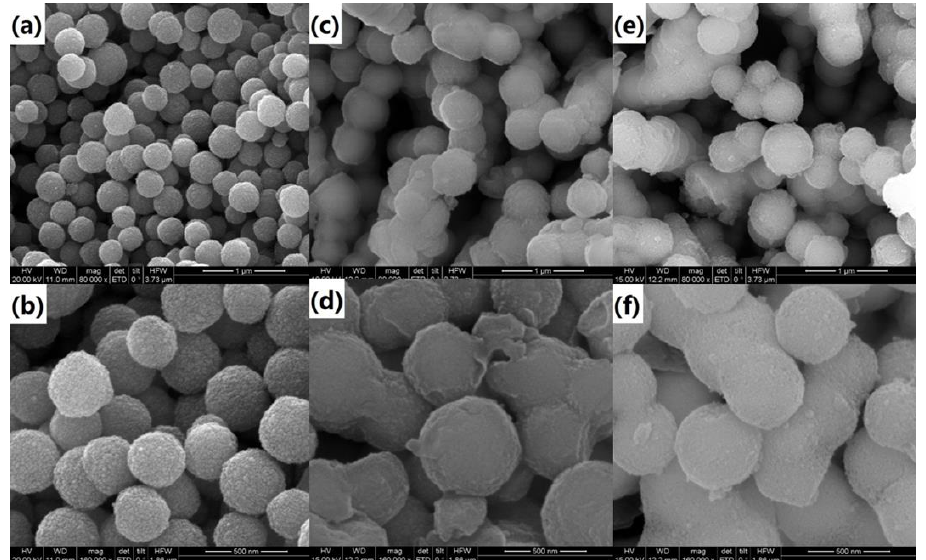
Figure 3. SEM images of Fe 3 O 4 microsphere ( a , b ), Fe 3 O 4 @MIL-100 (Fe) support ( c , d ), and the immobilized lipase ( e , f ). immobilized lipase ( e , f